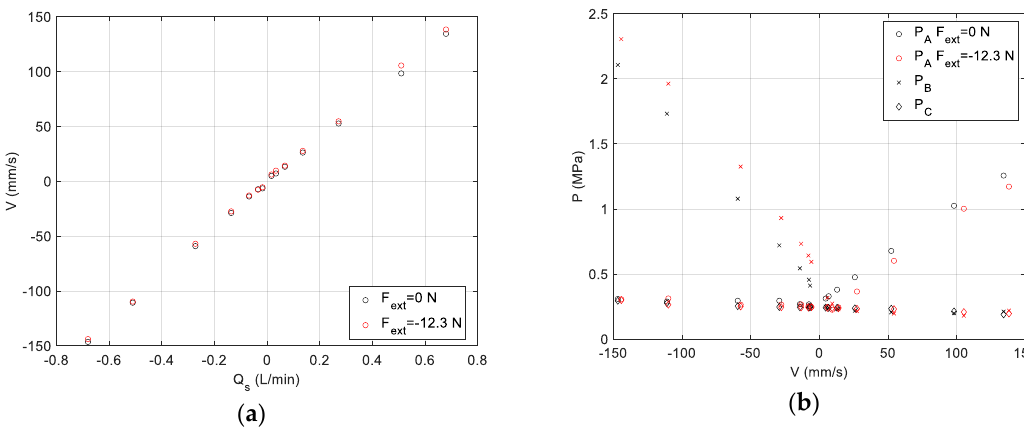
Figure 6. Experimental data for system with Valve A (steel sleeve and spool) for two loading conditions: ( a ) actuator velocity with respect to commanded pump speed; ( b ) pressures with respect to actuator velocity.